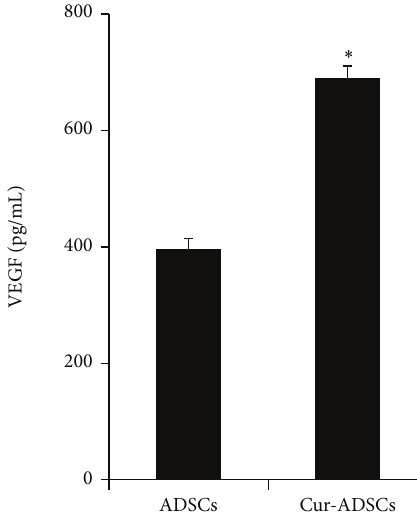
Figure 3: Effect of curcumin pretreatment on paracrine effect. A significant production of VEGF from ADSCs pretreated by curcumin was observed when compared with nontreated ADSCs control ( 𝑃 < 0.05 ). ∗ 𝑃 < 0.05 versus